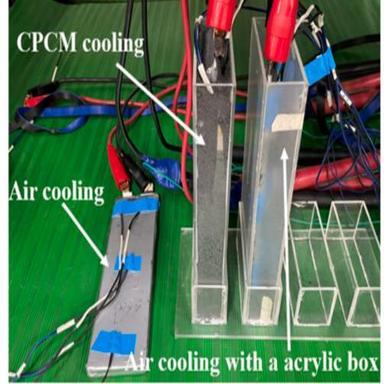
Experimental platform for charge and discharge test.